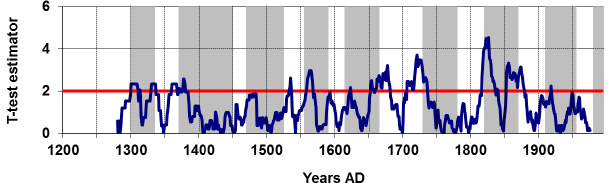
Figure 5. Differences of sliding means by the 31-year running t test estimator of flood frequencies of the Bavarian Foreland; the thresh- old value for the two-sided t test is 2.00 (see red line). Grey bars indicate flood-rich periods